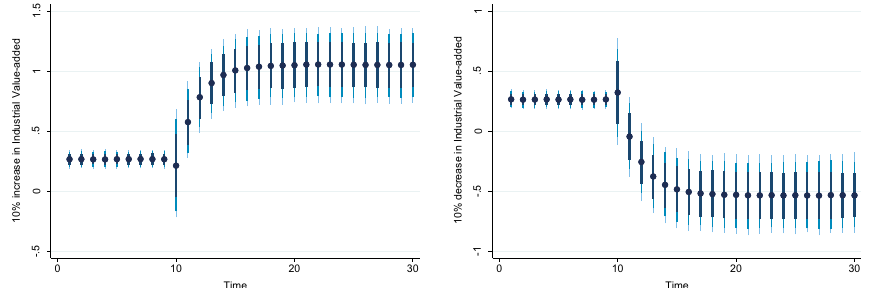
Fig. 8 The Impulse Response Plot for industrial value-added and CO 2 emissions. This figure shows a 10% increase and a decrease in industrial value-added and its influence on CO 2 emissions where dots specify average prediction value. However, the dark blue to light blue line denotes 75, 90, and 95% confidence interval,